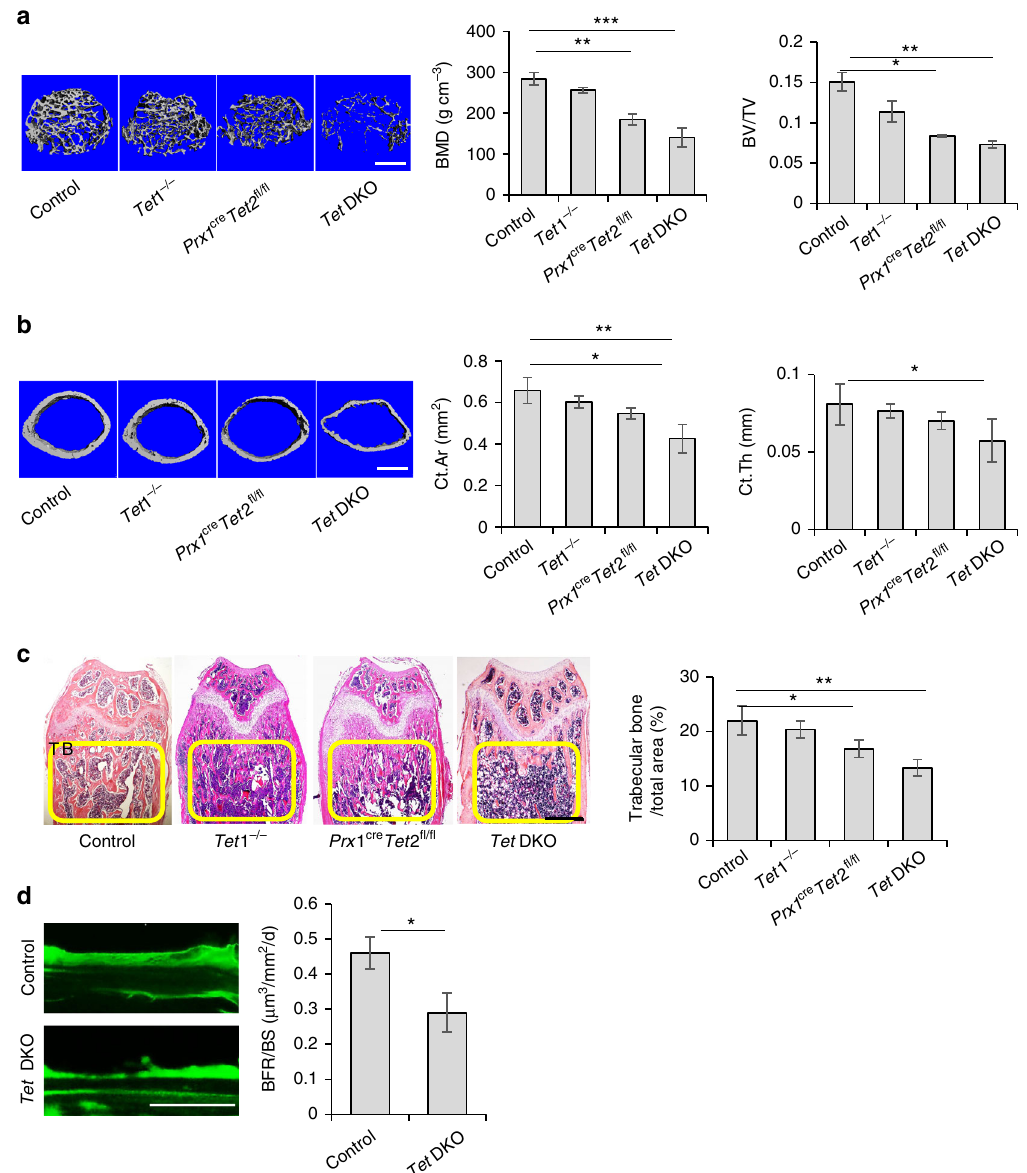
Fig. 2 Tet DKO mice show an osteopenia phenotype. a Bone volume/tissue volume (BV/TV) of trabecular bone area in the femurs of control, Tet1 − / − , Prx1 cre Tet2 fl / fl , and Tet DKO mice were analyzed by micro-CT. b The cortical bone area (Ct.Ar) and cortical thickness (Ct.Th) in the femur of control, Tet1 − / − , Prx1 cre Tet2 fl / fl , and Tet DKO mice were assessed by micro-CT. c H&E staining showed the trabecular bone volume (yellow-circled area) in the distal femurs of control, Tet1 − / − , Prx1 cre Tet2 fl / fl , and Tet DKO mice. d Calcein double labeling assay showed the bone formation rate in the metaphyseal trabecular bone of control and Tet DKO mice. The 8 – 10-week-old Tet1 − / − Prx1 cre Tet2 fl / fl mice were used as Tet DKO mice in these experiments, and their littermates whose genetic status was Prx1 cre were used as controls. * p < 0.05, ** p < 0.01, *** p < 0.001 (mean ± SD). Scale bars, 400 μ m ( a , b ), 1 mm ( c ), and 25 μ m ( d ). Results are from three independent experiments. p values were calculated using one-way ANOVA ( a - c ) and two-tailed Student's t test ( d